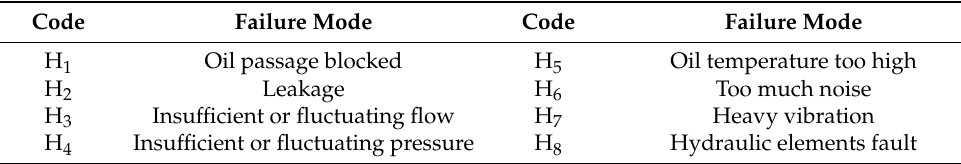
Table 4. Main sub-event failures of a hydraulic system.